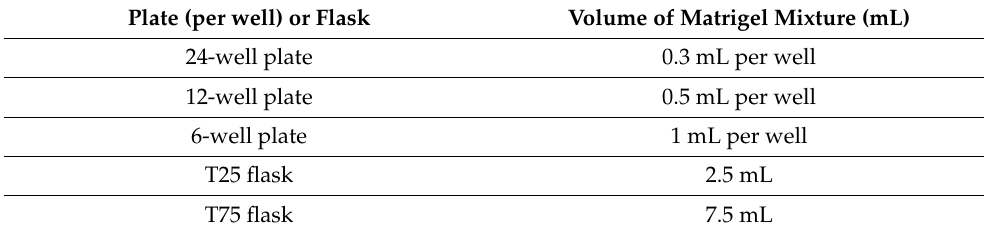
Table 1. Volume of Matrigel solution needed per plate or